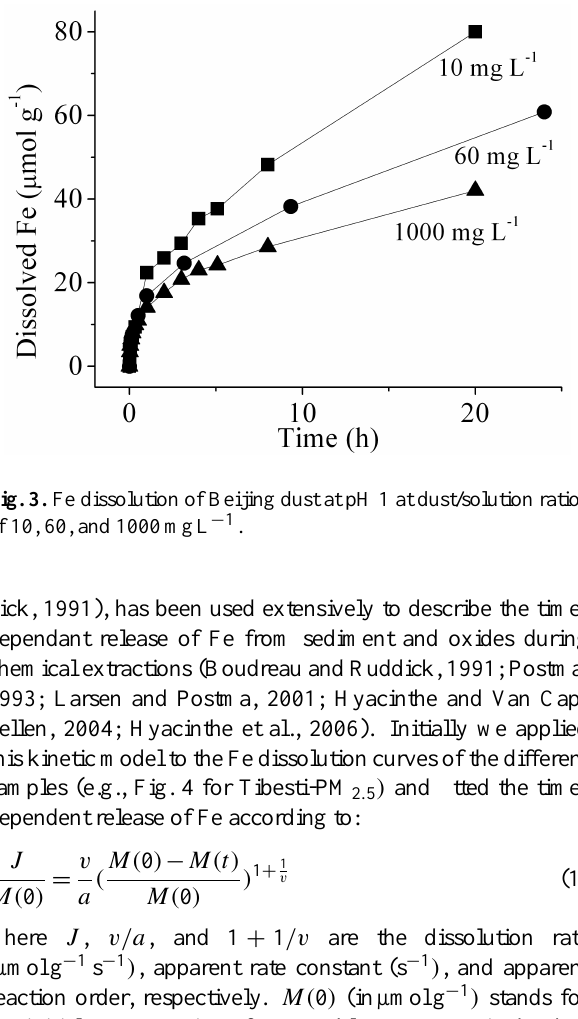
Fig. 2. Fe dissolution kinetics of Tibesti-PM 20 and Beijing dust samples at pH 1, 2 and 3 and at a dust/liquid ratio of 60mgL − 1 .